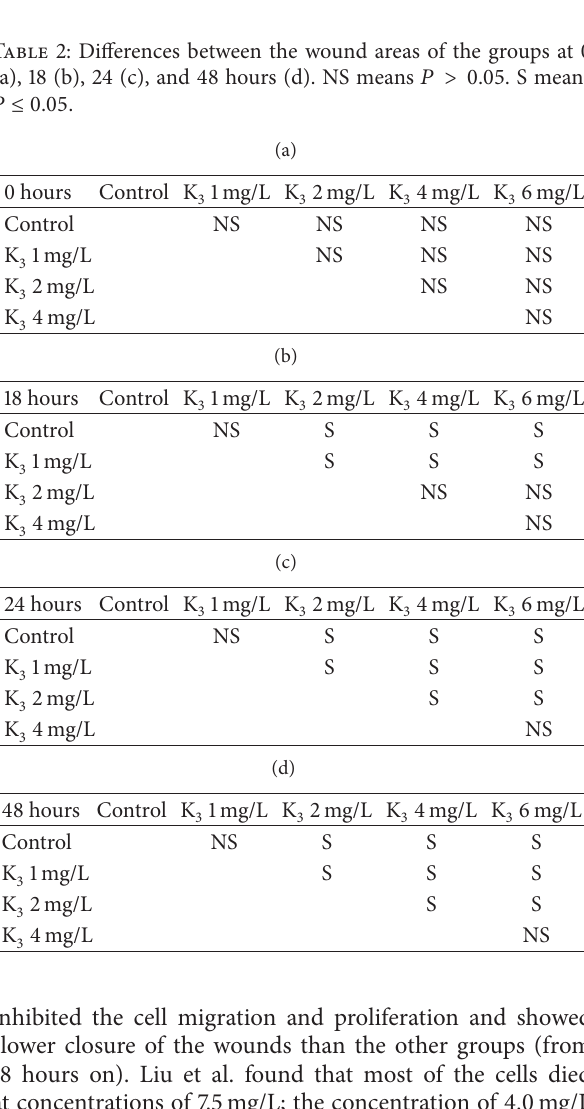
Table 2: Differences between the wound areas of the groups at